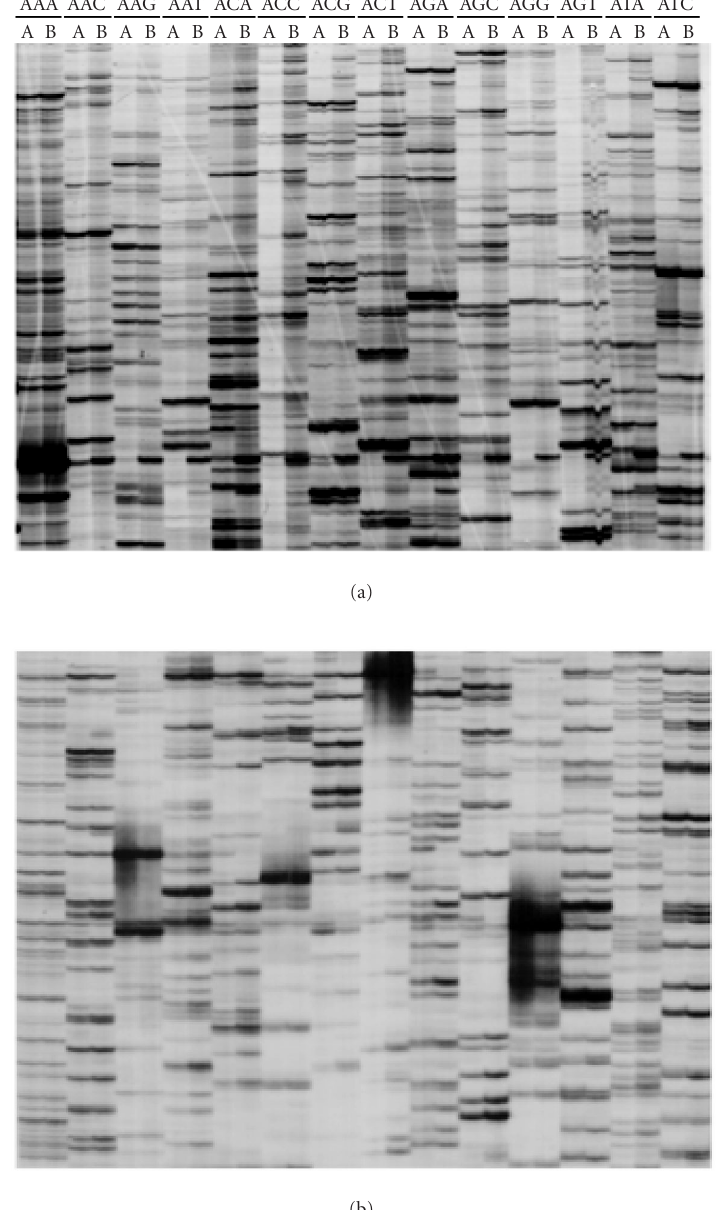
Figure 7. AFLP amplification is dependent on the terminal 3 (cid:3) nucleotide sequence of the AFLP primer in the second, but not in the first PCR. The Eco RI oligonucleotide primer E36 with three additional 3 (cid:3) nucleotides (5 (cid:3) -GACTGCGTACCAATTCACC-3 (cid:3) ) was used with a range of Mse I primers, each with a di ff erent combination of three additional 3 (cid:3) nucleotides. For all lanes marked A, the same Mse I oligonucleotide primer was used in the first and second PCR. For all lanes marked B, one specific Mse I primer, M31, was used in the first PCR, and then another Mse I primer was used in the second PCR. The additional 3 (cid:3) nucleotides on M31 were 5 (cid:3) -AAA-3 (cid:3) , and the additional 3 (cid:3) nucleotides on the primer used in the second PCR to generate the AFLP profile are listed above the lanes (5 (cid:3) to 3 (cid:3) ). The AFLP profiles were generated for (a) sugarcane hybrid 79A362 and (b) soybean cv.